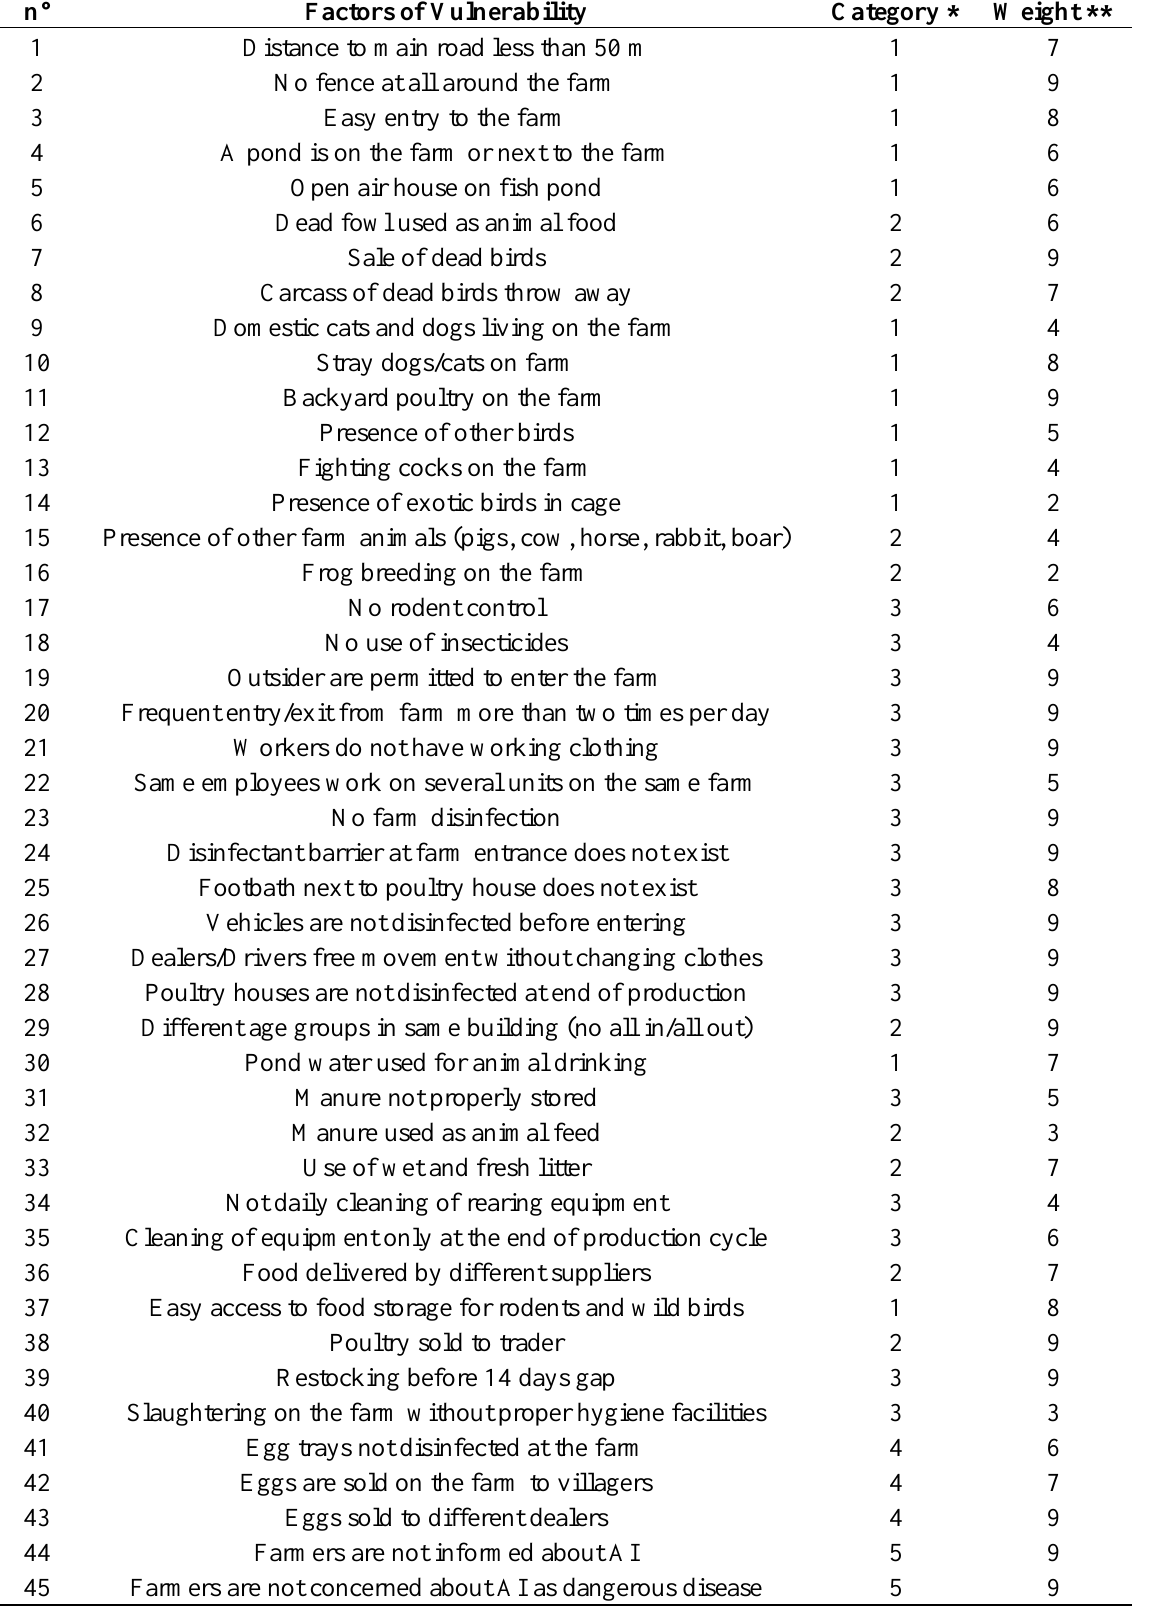
Table 1. Collected factors of vulnerability and related category and